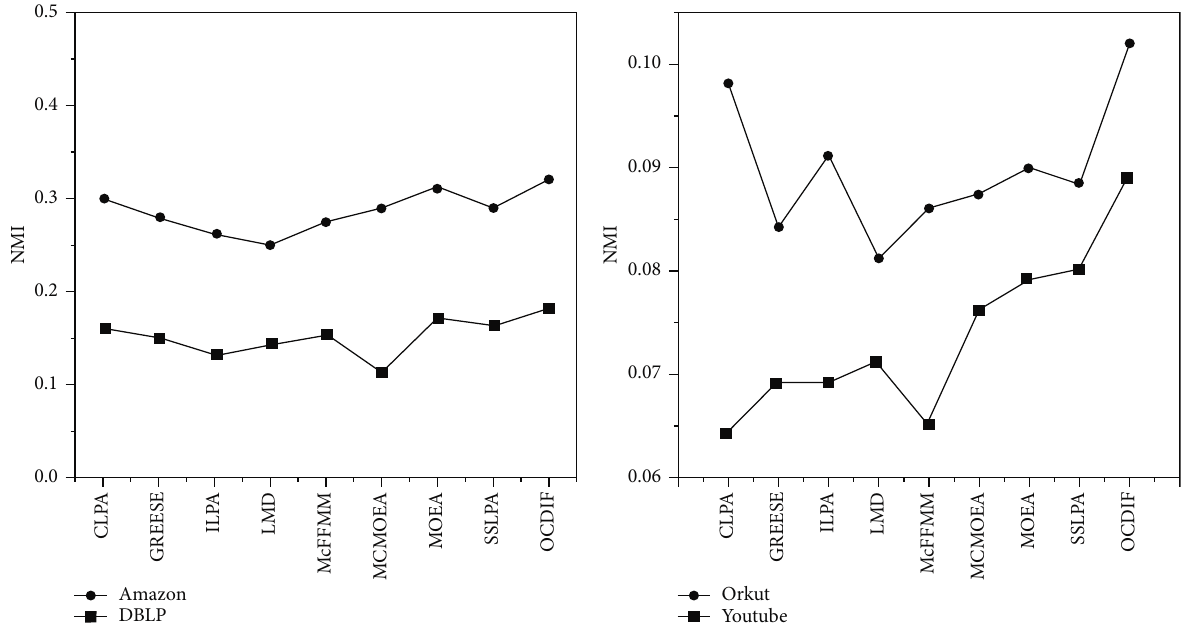
Figure 7: NMI value on networks. Table 1: Comparison of the algorithm’s accuracy in So-Colgate network and PowerGrid network.